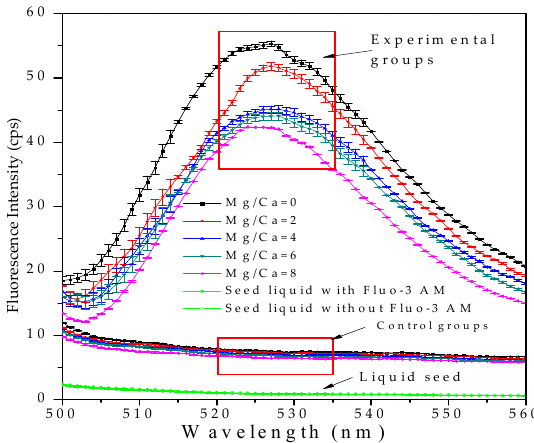
Figure 8. Fluorescence intensities of intracellular Ca 2 + ions at various Mg / Ca ratios.